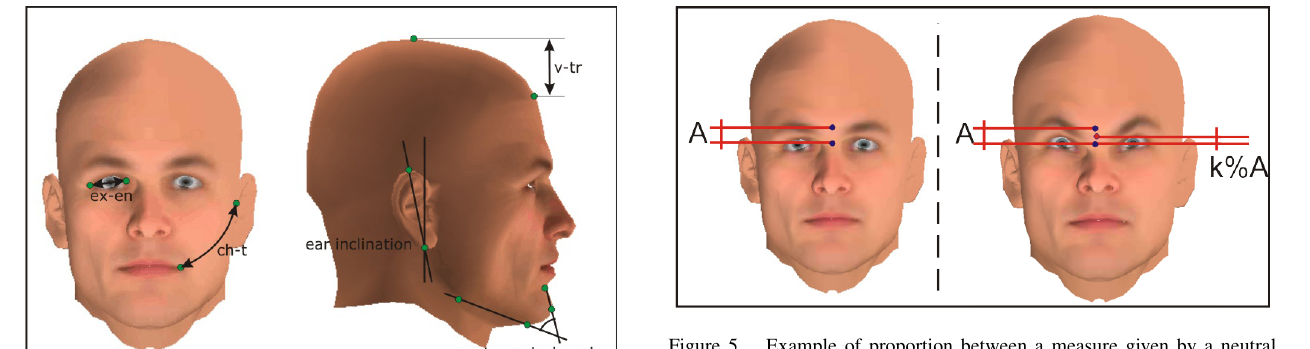
Figure 5. Example of proportion between a measure given by a neutral face and by a face with an